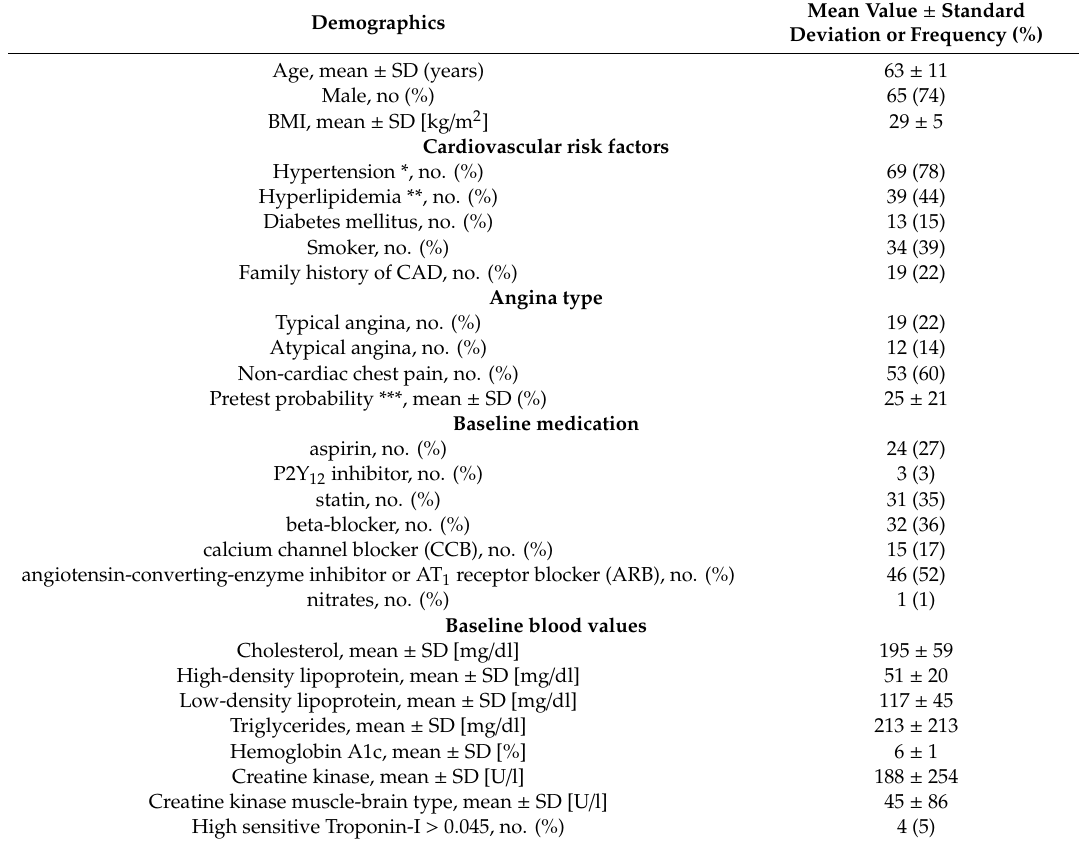
Table 1. Baseline characteristics ( n =